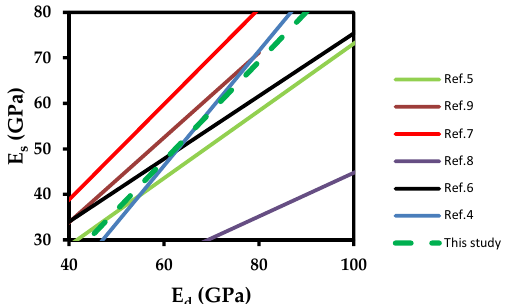
Figure 6. Comparison of previously published linear relationship with the equation developed in this study.